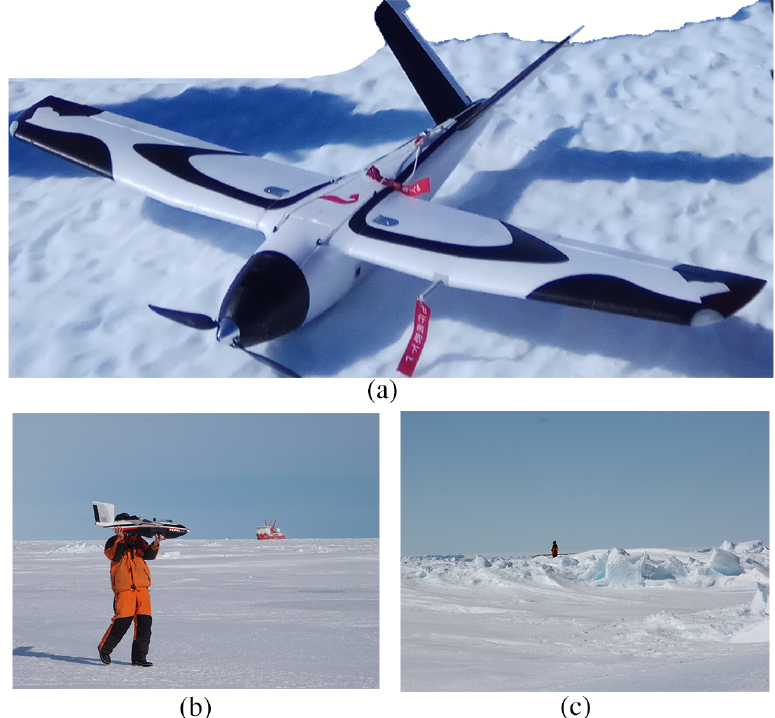
Figure 2. UAS model illustration and field work scenes. ( a ) Polar Hawk-III model. Refer to Section 3.1 for the model’s detailed specifications. ( b ) Holding the model, the operator is about to cast it into air to deploy the vehicle. Note the R/V Xuelong, 400 m in the background. ( c ) A photo of a small area of rough ice. The stiff ice floes stand out chaotically, up to about 0.5 ∼ 1 m. Please refer to the person (height: 1.75 m) behind for physical